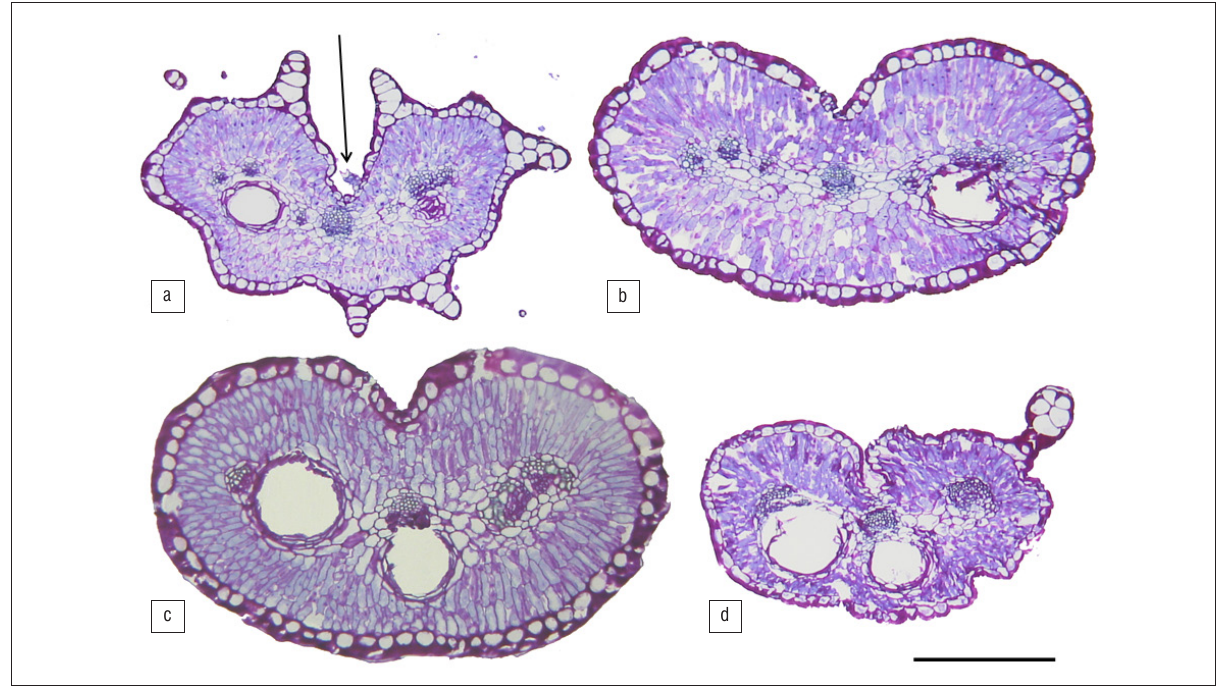
Figure 2: Transverse sections of leaves from four varieties of Pteronia camphorata . (a) P. camphorata var. armata , (b) P. camphorata var. camphorata , (c) P. camphorata var. laevigata , and (d) P. camphorata var. longifolia . Oil glands are present in all, and secretory trichomes in (a) and (d). Key: The arrow indicates a secretory trichome; scale bar = 0.4